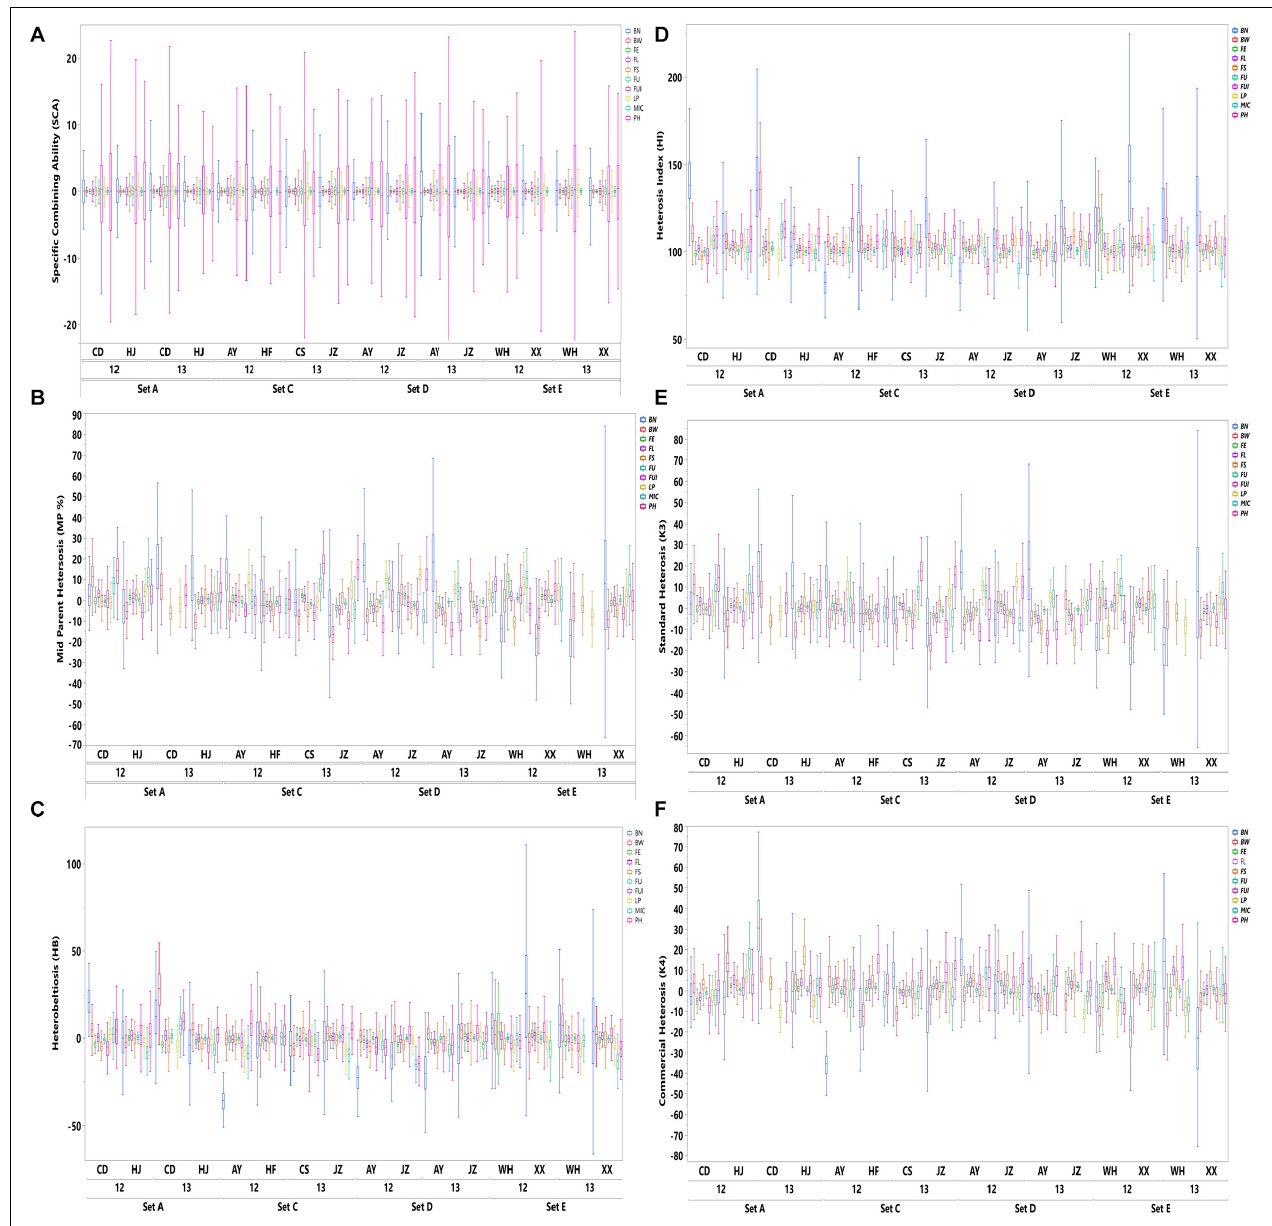
FIGURE 2 | Distribution of SCA and five heterosis types (HB, MP, HI, K3, and K4) of agronomic and fiber quality traits among four F 1 hybrid sets (SetA, SetC, SetD, and SetE) across multiple environments for years 2012 and 2013. Legends on the top right in different colors are depicting ten evaluated phenotypic traits.